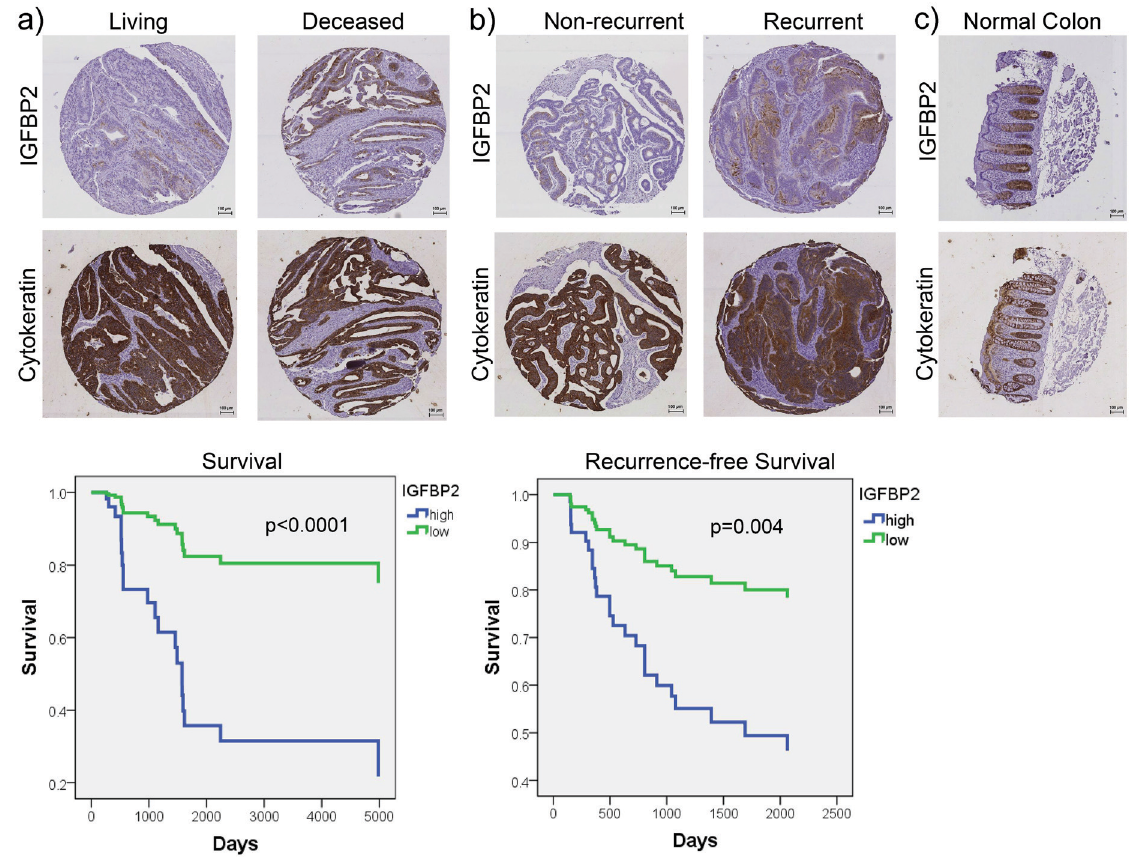
Figure 3. IGFBP2 expression is associated with recurrence and death in CRC in a secondary dataset. IHC immunostaining of a CRC tissue microarray for IGFBP2 and cytokeratin (epithelial marker) was performed. a ) Representative IGFBP2 staining in living and deceased patients and Kaplan-Meier curve comparing survival of patients with low (below median) vs. high (at or above median) IGFBP2 staining. b ) Representative IGFBP2 staining in non-recurrent and recurrent patients and Kaplan-Meier curve comparing recurrence-free survival of patients with low (below median) vs. high (at or above median) IGFBP2 staining. %IGFBP2-positive area of tumor was calculated using IGFBP2 area and cytokeratin area to identify tumor. Survival and recurrence-free survival plots are adjusted for stage. c ) Representative IGFBP2 and cytokeratin staining in a representative normal colon sample. Scale bars indicate 100